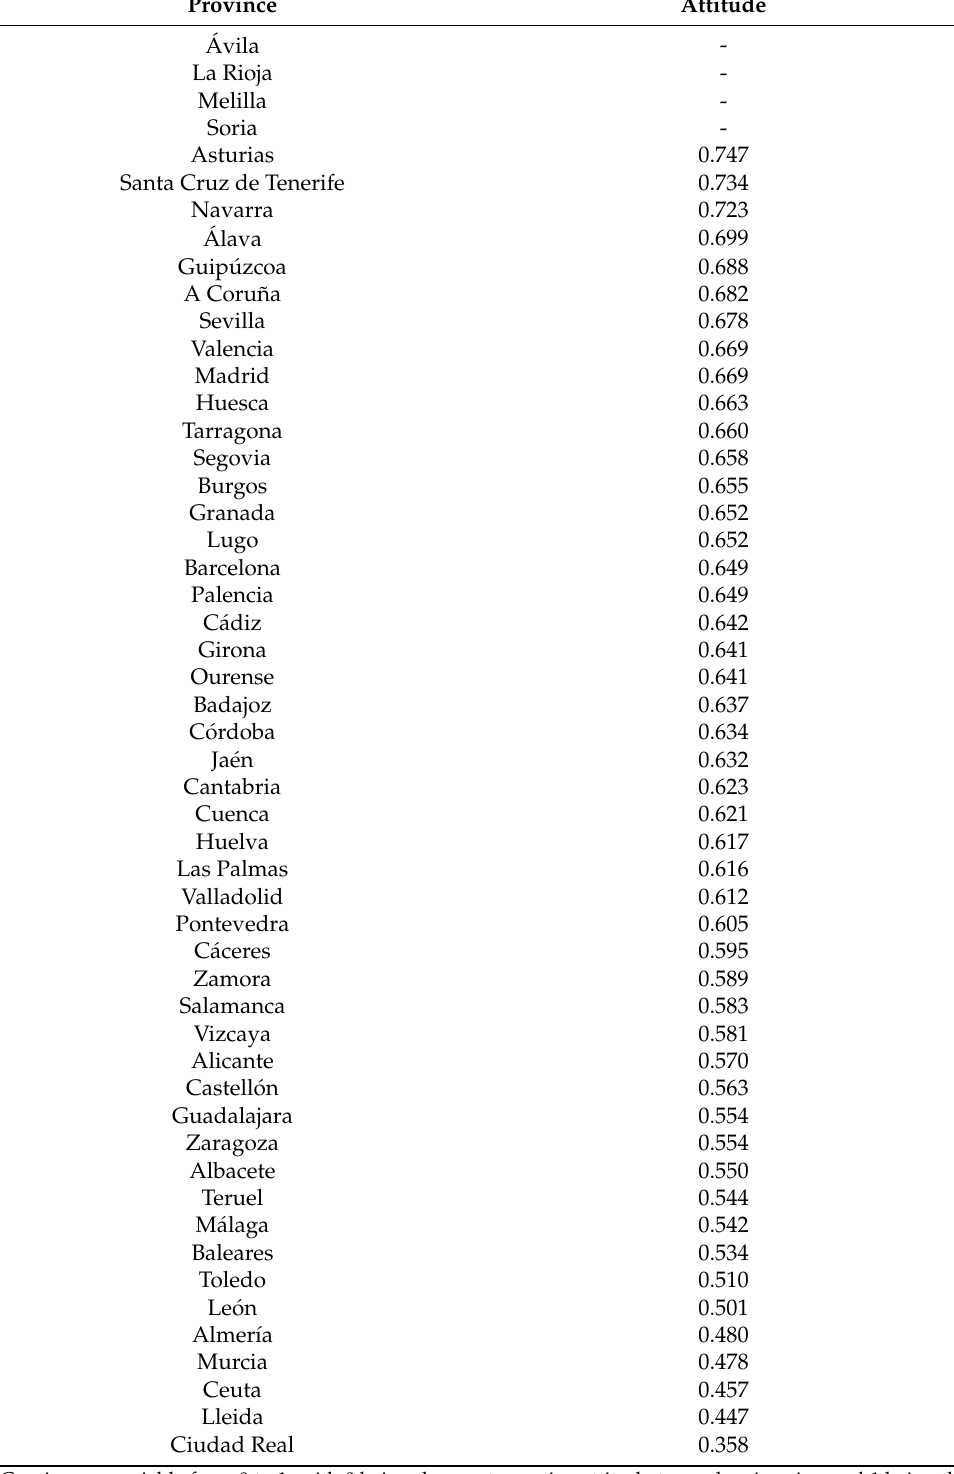
Table A2. Average acceptance towards immigration in Spain 1 by provinces (NUTS